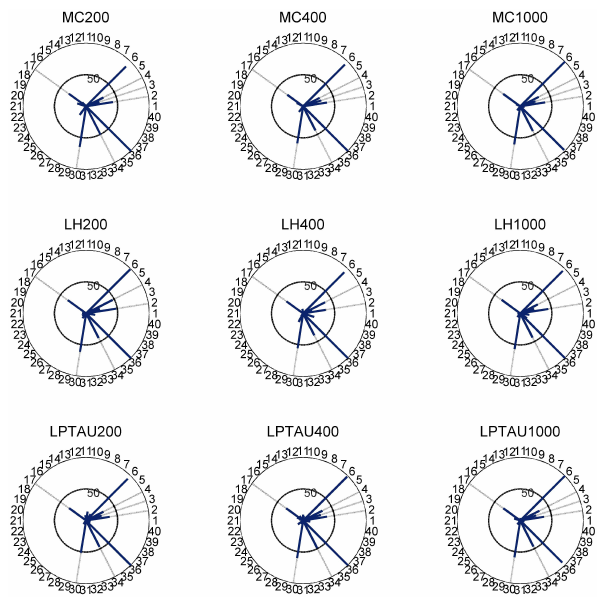
Fig. 3. The sensitivity score of sensible heat given by MARS. The length of needles represents the sensitivity score.